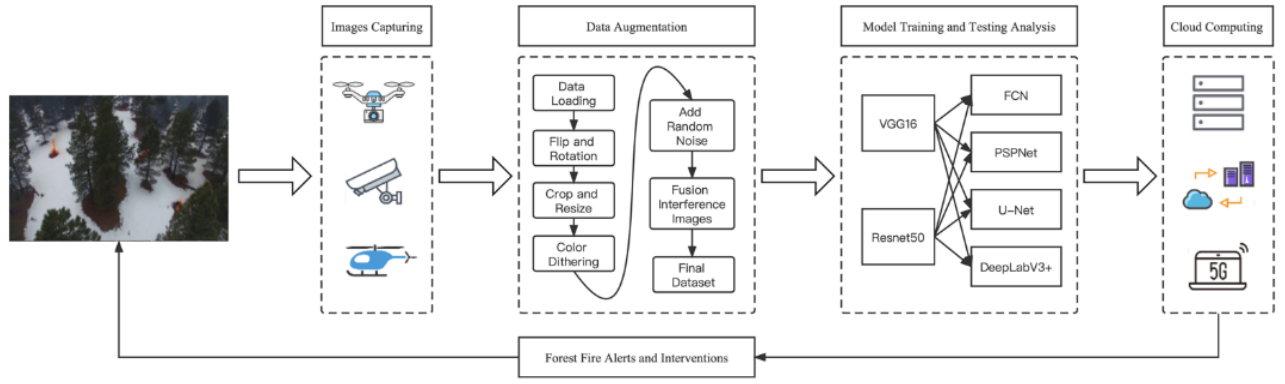
Figure 1. Overall process of the experiment.